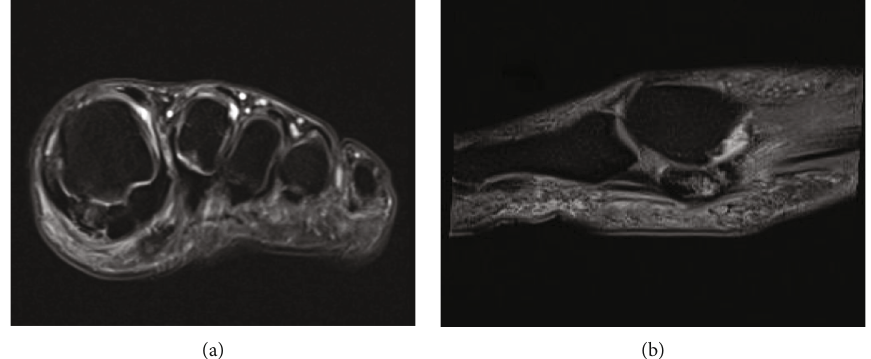
Figure 2: Magnetic resonance imaging of the left foot demonstrating bipartite medial sesamoid, di ff use homogeneous bone marrow edema of the medial sesamoid, periarticular soft tissue edema, and small glenosesamoid joint e ff usion ((a) coronal T2 with fat saturation, (b) sagittal T2 with fat saturation).